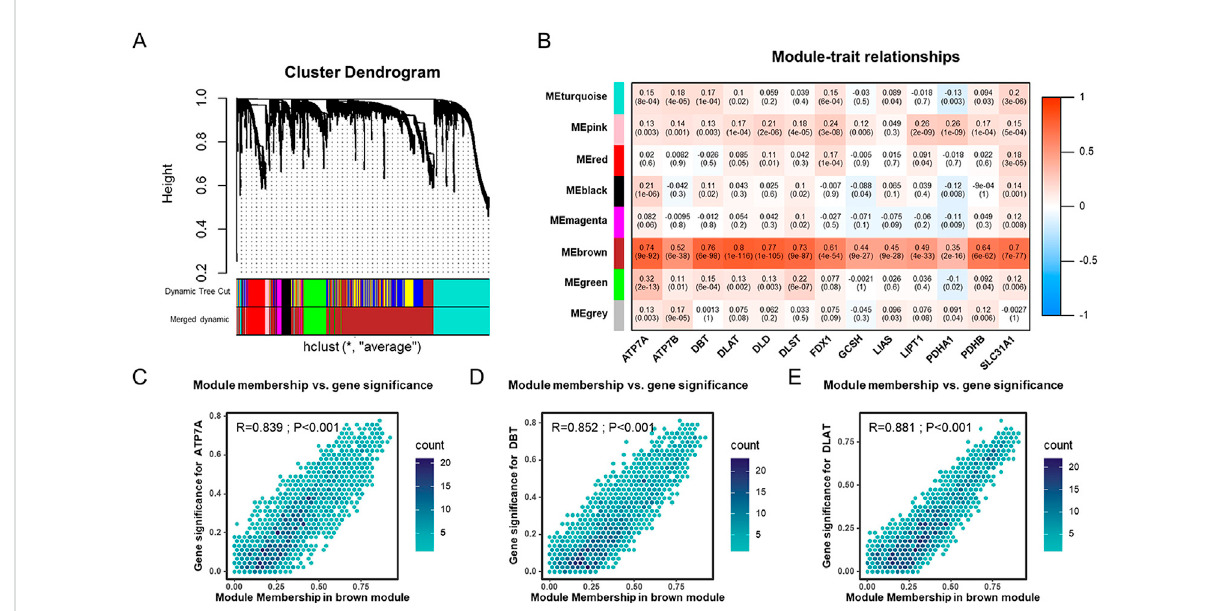
FIGURE 3 Identi fi cation of cuproptosis-related genes in the TCGA-UCEC cohort through WGCNA (A) . Dendrogram of all cuproptosis genes clustered based on a dissimilarity measure (1-TOM). (B) The heatmap of the correlation between module eigengenes and cuproptosis genes in TCGA-UCEC cohort. (C – E) The scatter plots of module eigengenes in MEbrown